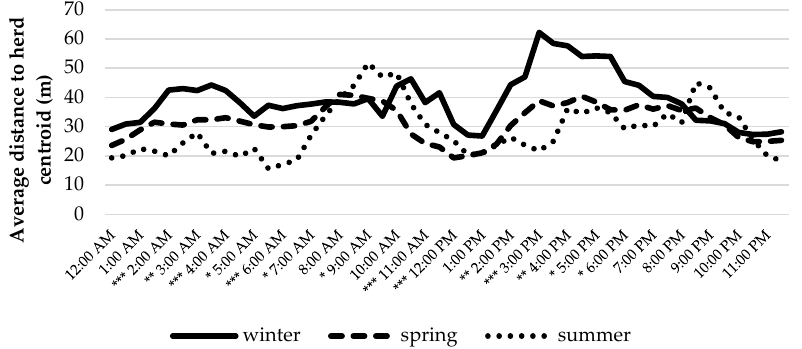
Figure 8. Seasonal variability of herd behavior. Asterisks indicate statistical significance: * = p < 0.05; ** = p < 0.01; *** = p < 0.001. The temporal variability of animal distribution influenced the distribution of dung. Two single sampling plots located in a flat area between 50 and 100 m from the water trough, which represented 2.2% of the total area sampled, accumulated 24.3% of droppings during the whole study period (from now on, we refer to these two plots as hotspots). However, that percentage differed among weeks, ranging from 8.0% to 41.2% (Figure 9). Such percentage was increased with ambient temperature due to the higher presence of animals in areas close to the water during warm days (Figure 10). While animals spent most of their time in areas far from the water trough (>200 m) during days with an average temperature below 15 ◦ C, time was equally distributed between far areas and those situated between 50 and 100 m from water when the average temperature rose to 22 ◦ C and above.